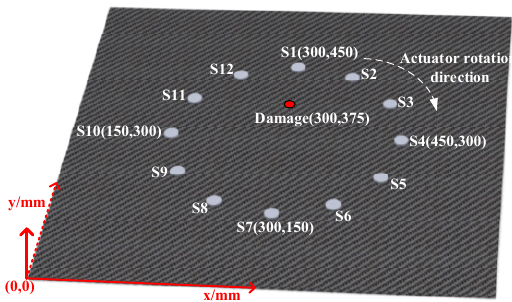
Figure 4. Schematic diagram of sensor and damage location.